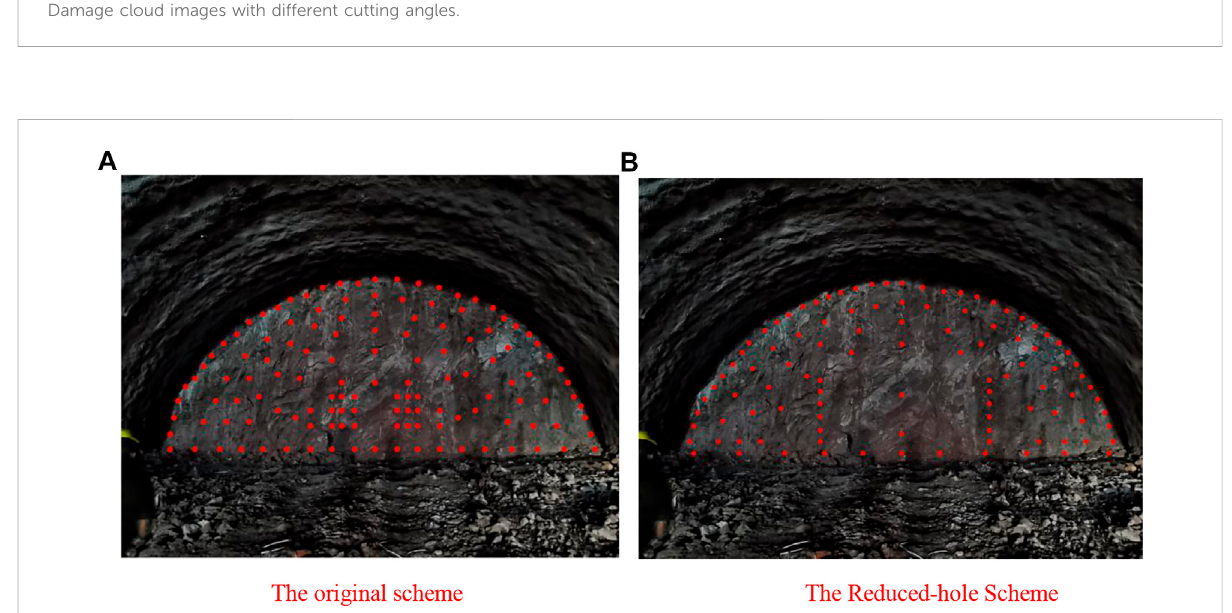
FIGURE 17 Hole network layout. (A) Original scheme. (B) Reduced-hole